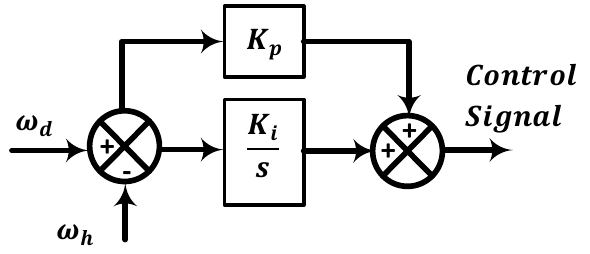
Figure 7. Proportional and integral controller